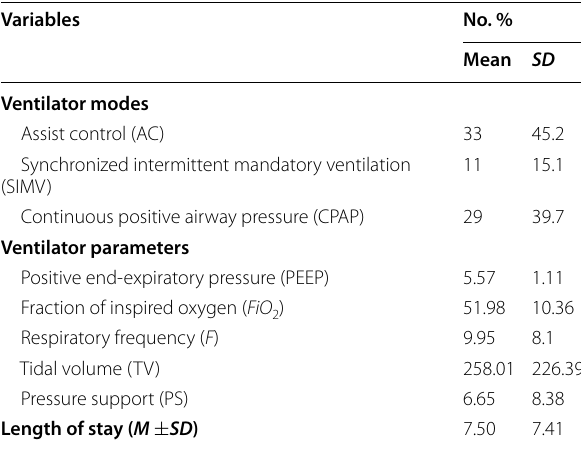
Table 4 Frequency distribution, mean and standard deviation